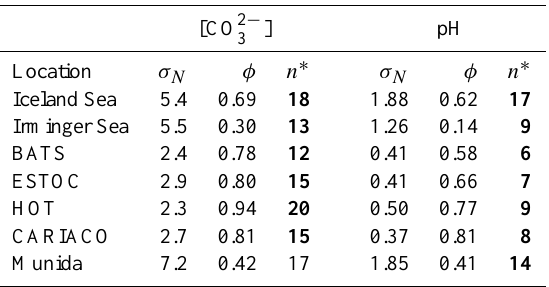
Table 1. The standard deviation ( σ N ) and autocorrelation ( φ ) in the de-seasonalized monthly anomalies of surface [CO 2 − ] (mmolm − 3 ) 3 and pH, and the length of the time series in years ( n ∗ ) needed to detect an (cid:127) aragonite trend of − 0.0078yr − 1 , and a pH trend of − 0.0018yr − 1 with 90% confidence at the stations discussed in Bates et al. (2014). Boldfaced values of n ∗ indicate that the detec- tion timescale is shorter than the length of the observational record at that location. [CO 2 − ] pH 3 Location σ N φ n ∗ σ N φ n